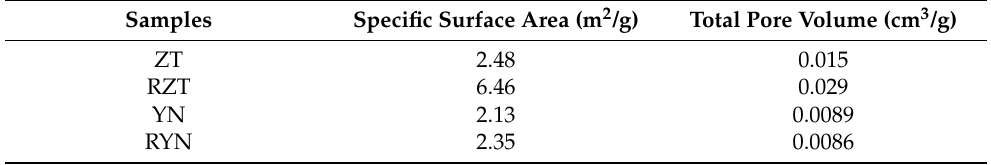
Table 3. Porous texture parameters of coal